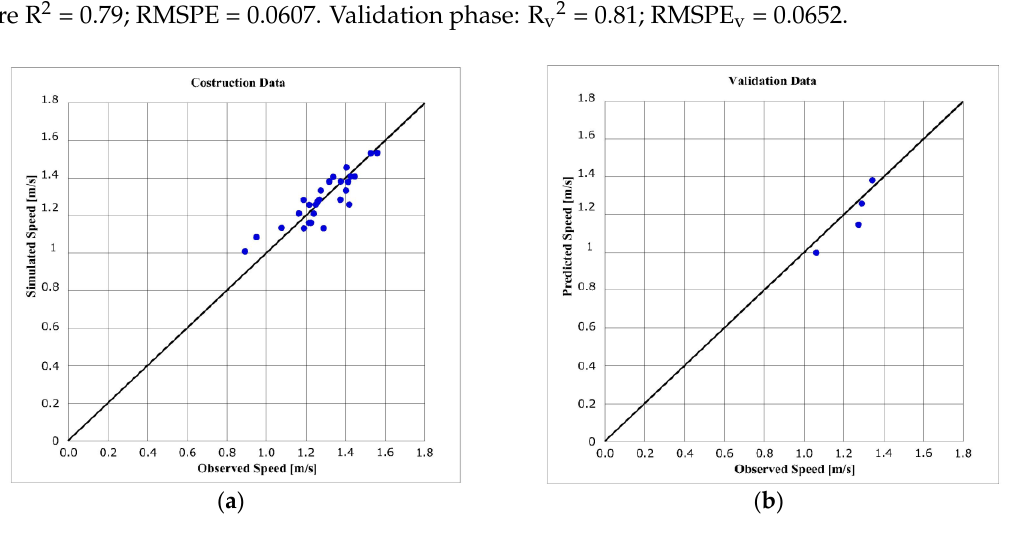
Figure 1. Comparison between observed and estimated datasets: construction phase ( a ); and validation phase ( b ).